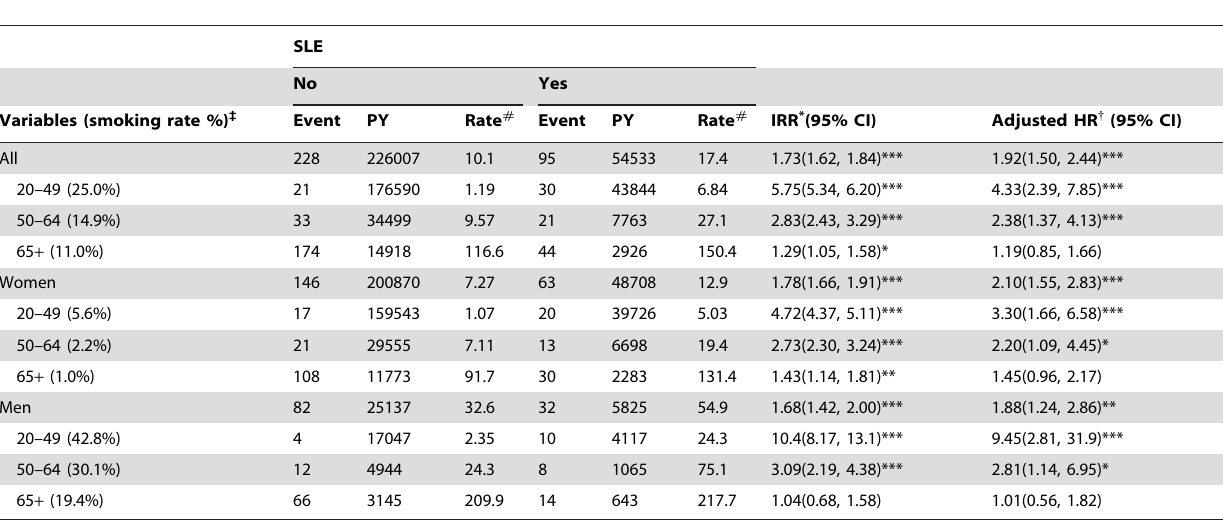
Table 2. Sex- and age-specific incidence rates of COPD in subjects with and without systemic lupus erythematosus (SLE) and Cox model estimated hazard ratios for patients with